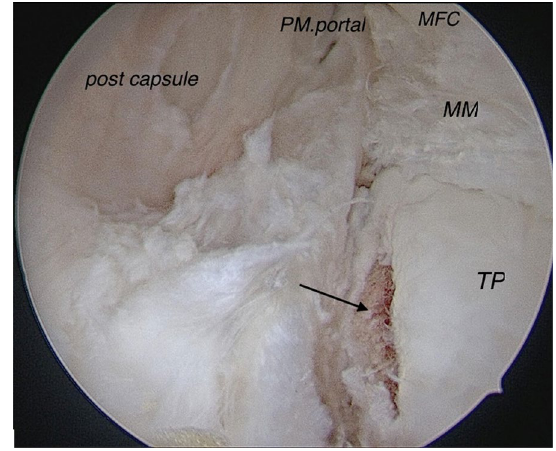
Fig. 3 The posteromedial non-cartilaginous rim of the tibial plateau below the torn meniscus was abraded using a bur to reach the cancellous bleeding bone. MM medial meniscus, TP tibial plateau, MFC medial femoral condyle, PM.portal posteromedial portal